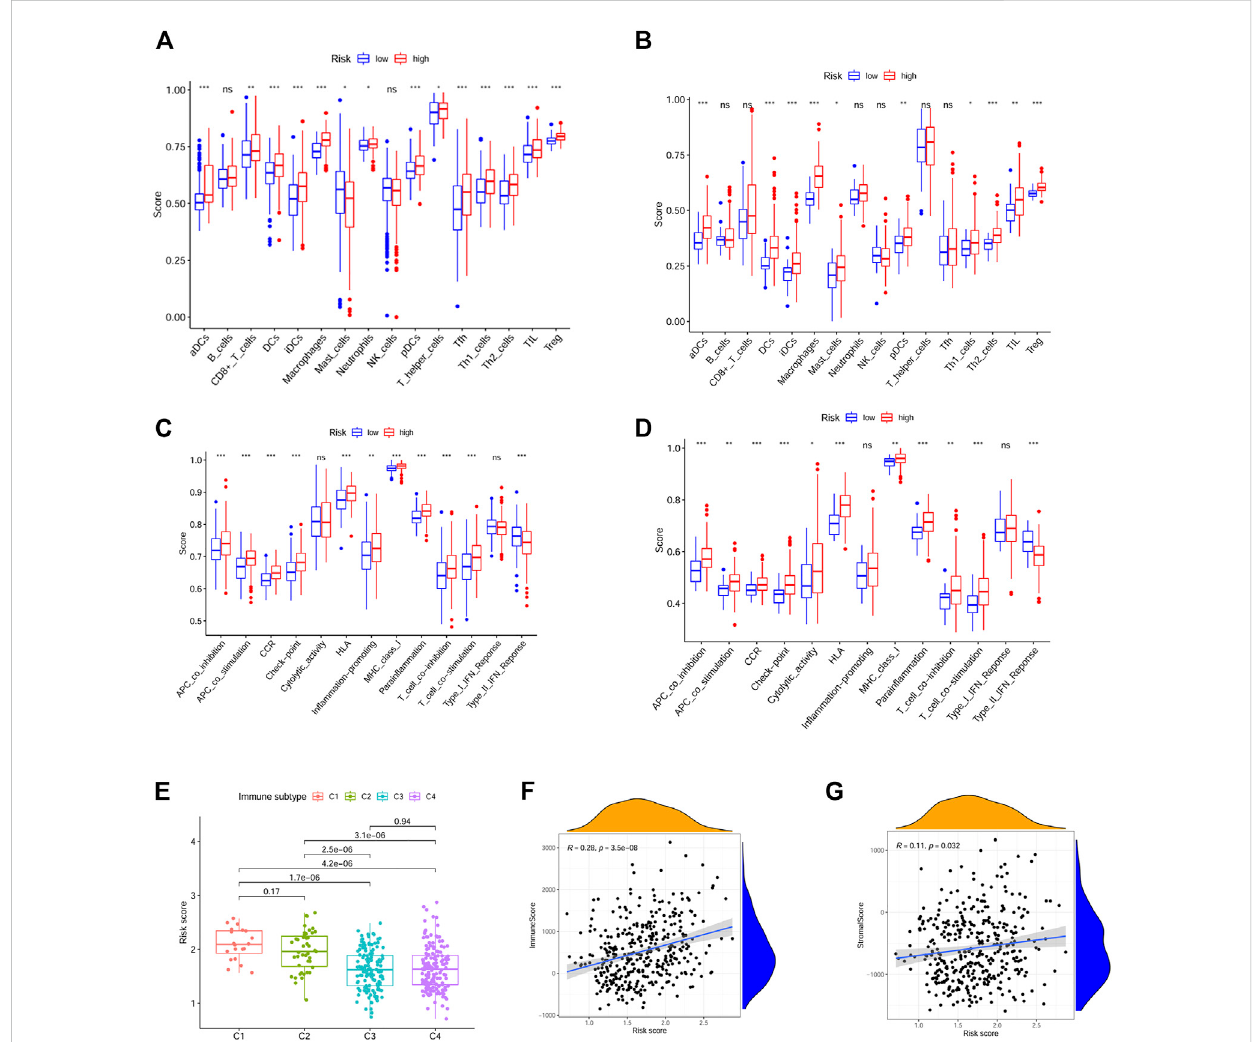
FIGURE 7 Immune in fi ltration between the high and low risk groups and drug resistance analysis. (A, C) Immune cells and immune-related pathways between the high-risk and low-risk groups in the TCGA dataset. (B, D) Immune cells and immune-related pathways between the high-risk and low-risk groups in the ICGC dataset. (E) Correlations between risk score and different immune subtypes. (F, G) Correlations between risk score and immune score, stromal score. ( p values were represented as: ns not signi fi cant; * p < 0.05; ** p < 0.01; *** p <